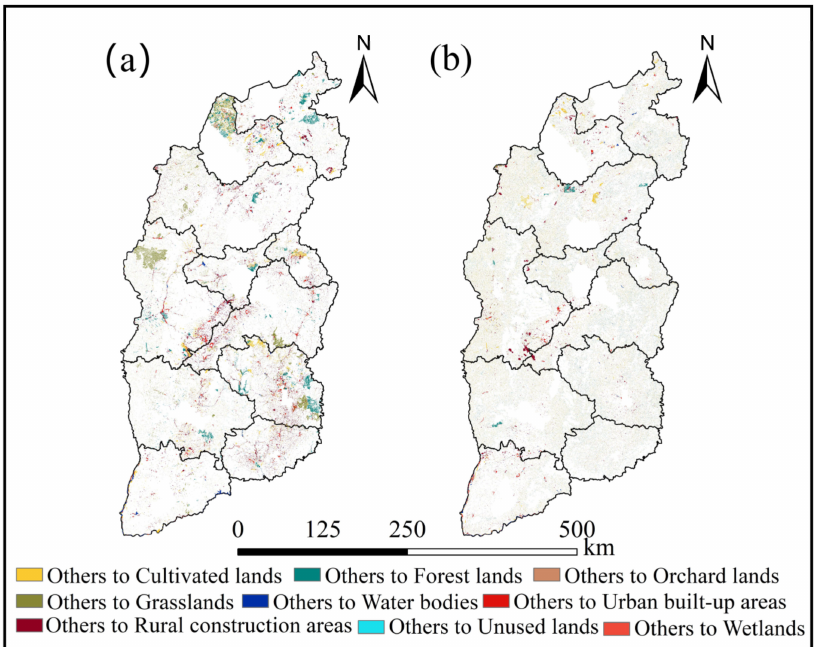
Figure 6. Spatial distribution of LUCCs in Shanxi from 2000–2010 ( a ), and 2010–2020 ( b